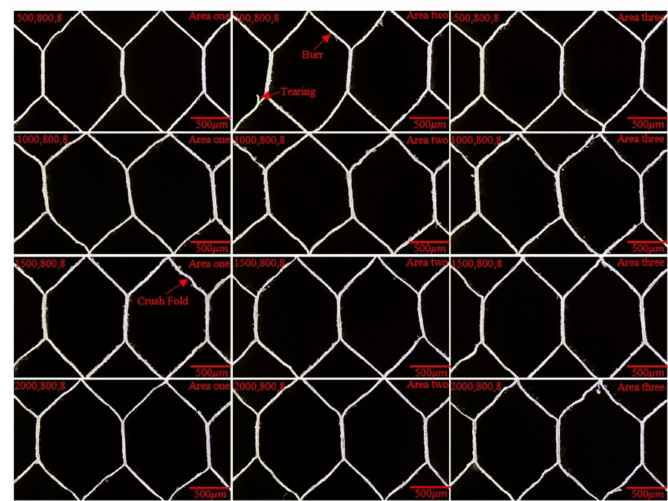
Figure 12. Surface morphology at different feed rate.